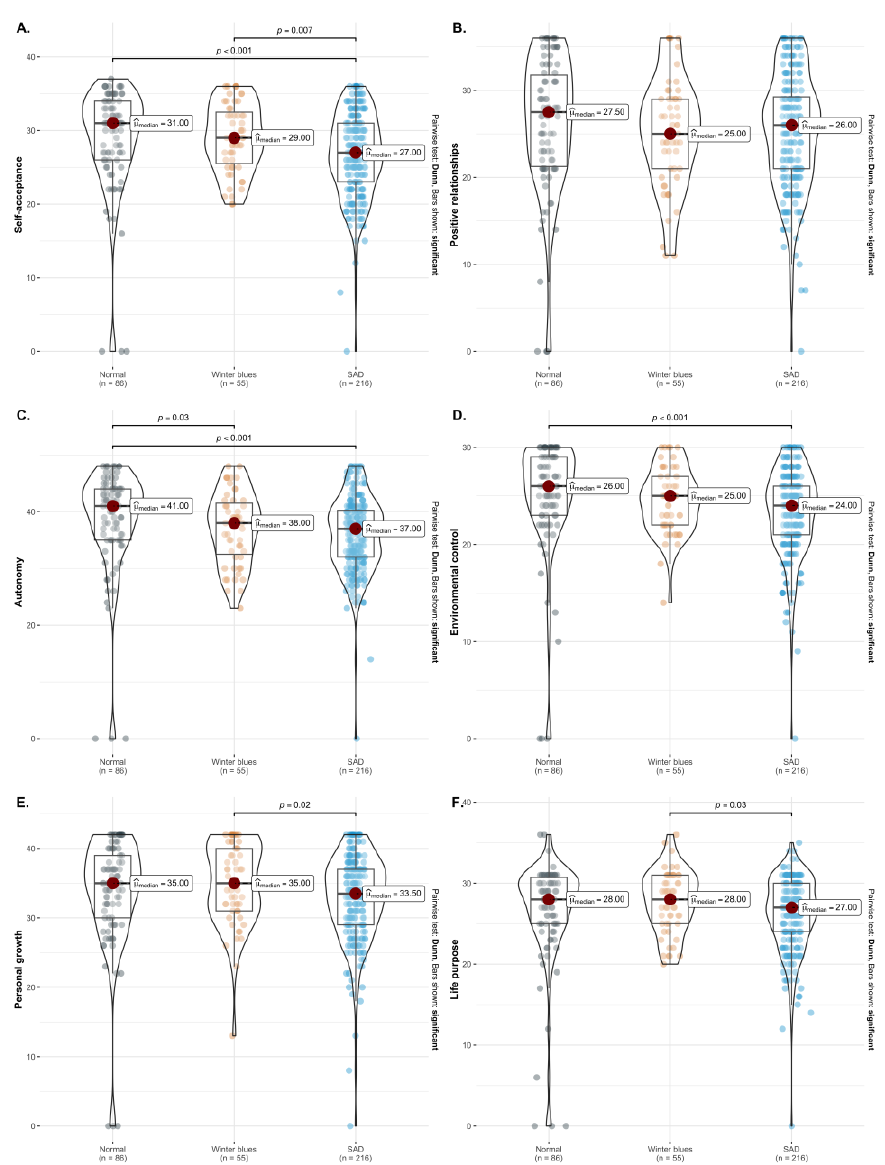
Figure 3. Violin plots indicate the observed differences between different SSI levels on Ryff’s parameters of psychological well-being. Dunn’s test was applied and highlighted for every significative pairwise difference for each panel. p -values are shown unadjusted for multiple comparisons (given the study’s exploratory nature).